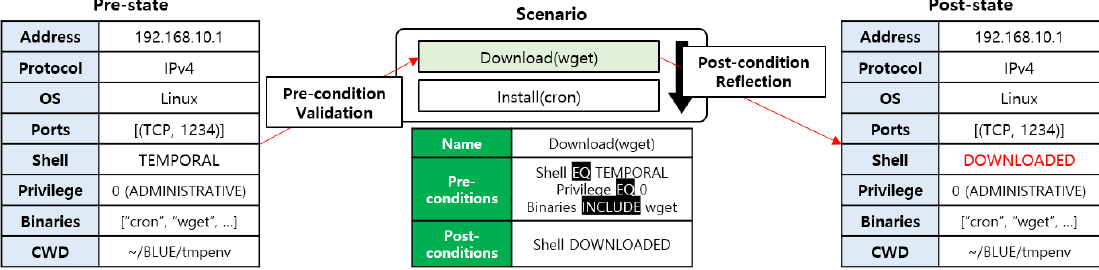
Figure 11. The example of the process of scenario performance: RAT download.